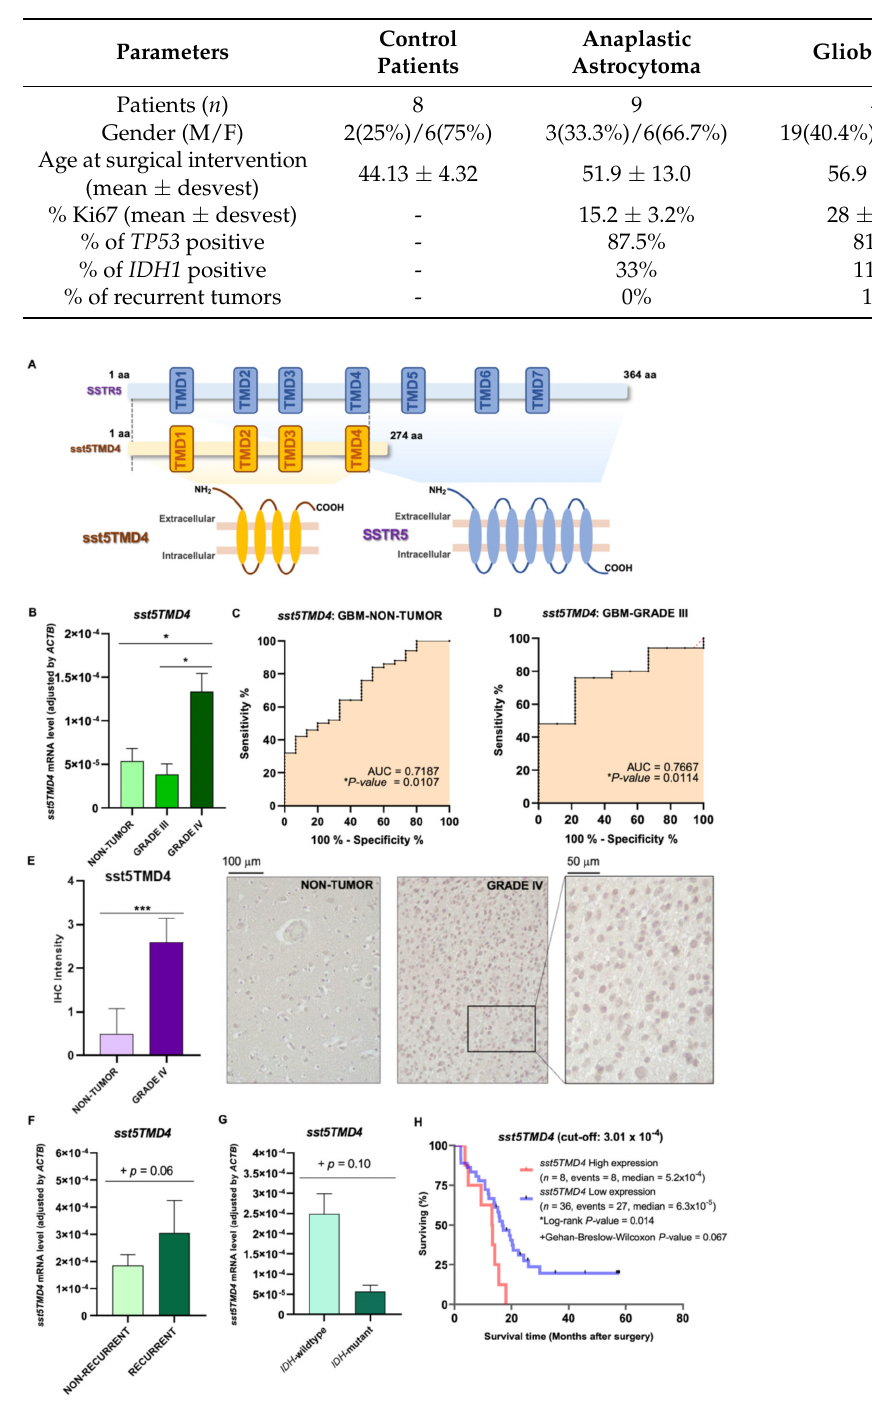
Table 1. Demographic and clinical parameters of patients with glioblastoma (GBM; n = 47) and anaplastic astrocytoma ( n = 9) included in this study. Non-pathologic brain control samples from donors ( n = 8) were obtained from autopsies [4 patients; 4 different brain areas (Brocca, Wernicke, cingulate, and medial)/patient; total of 16 samples] or epileptic patients (from lobectomy surgery; n = 4).